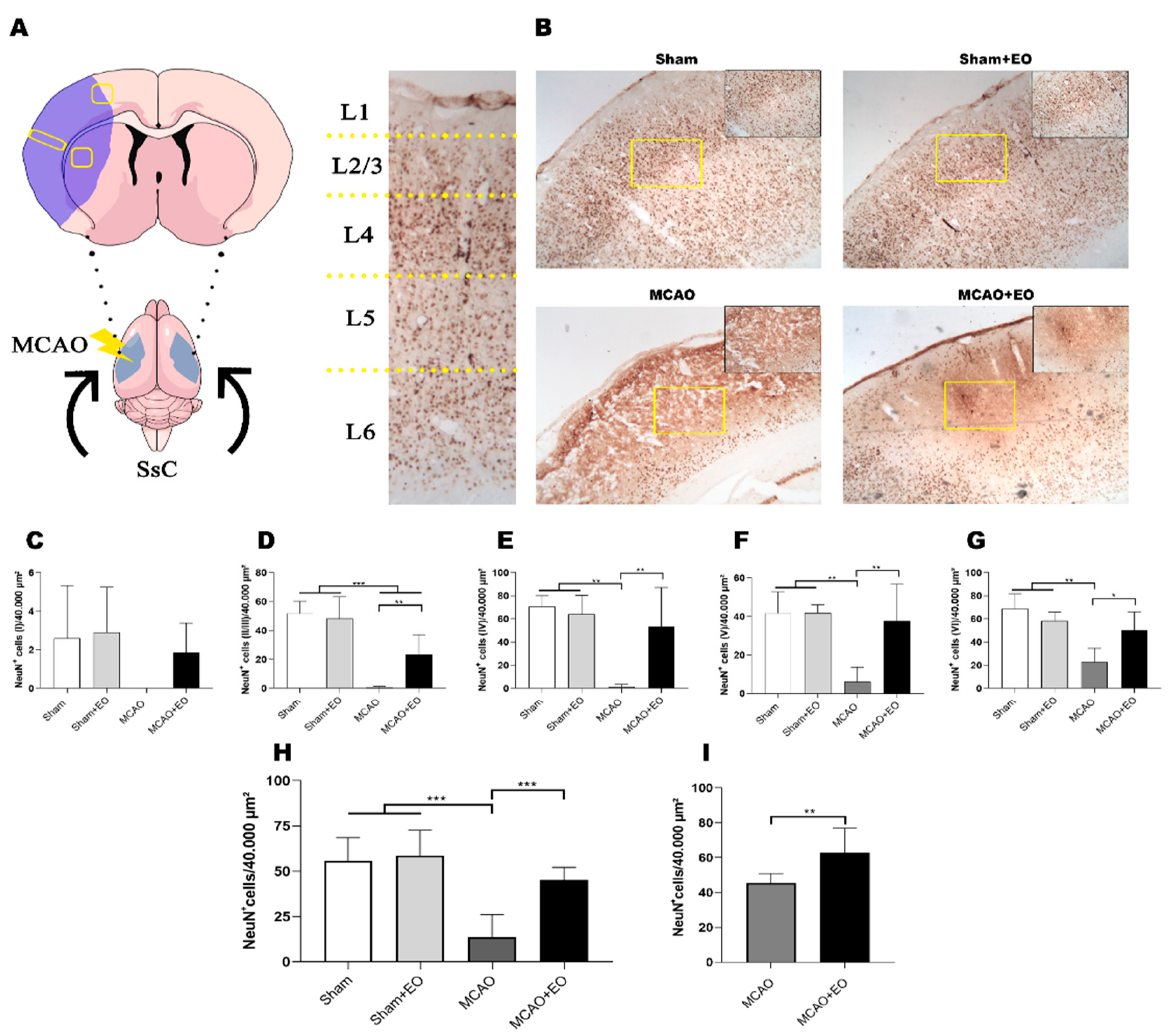
Figure 4. Neuronal death attenuated by the clarified Euterpe oleracea extract following middle cerebral artery occlusion (MCAO): ( A ) Brain map adapted from the area analyzed and the cortical layers. ( B ) Representative images of the experimental groups showing the area of cerebral infarction and stained with NeuN antibody. ( C ) Quantitative analysis of the NeuN + cells in layer I. ( D ) Quantitative analysis of the NeuN + cells in layers II/III. ( E ) Quantitative analysis of the NeuN + cells in layer IV. ( F ) Quantitative analysis of the NeuN + cells in layer V. ( G ) Quantitative analysis of the NeuN + cells in layer VI. ( H ) Quantitative analysis of the NeuN + cells in striatum. ( I ) Quantitative analysis of the NeuN + cells in area adjacent to the ischemic lesion (penumbra). The data are expressed as the mean ± SD ( n = 6 animals per group; C-H, two-way ANOVA followed by Tukey’s post hoc test; I, Student’s t test; * p < 0.05; ** p < 0.01; *** p < 0.001).